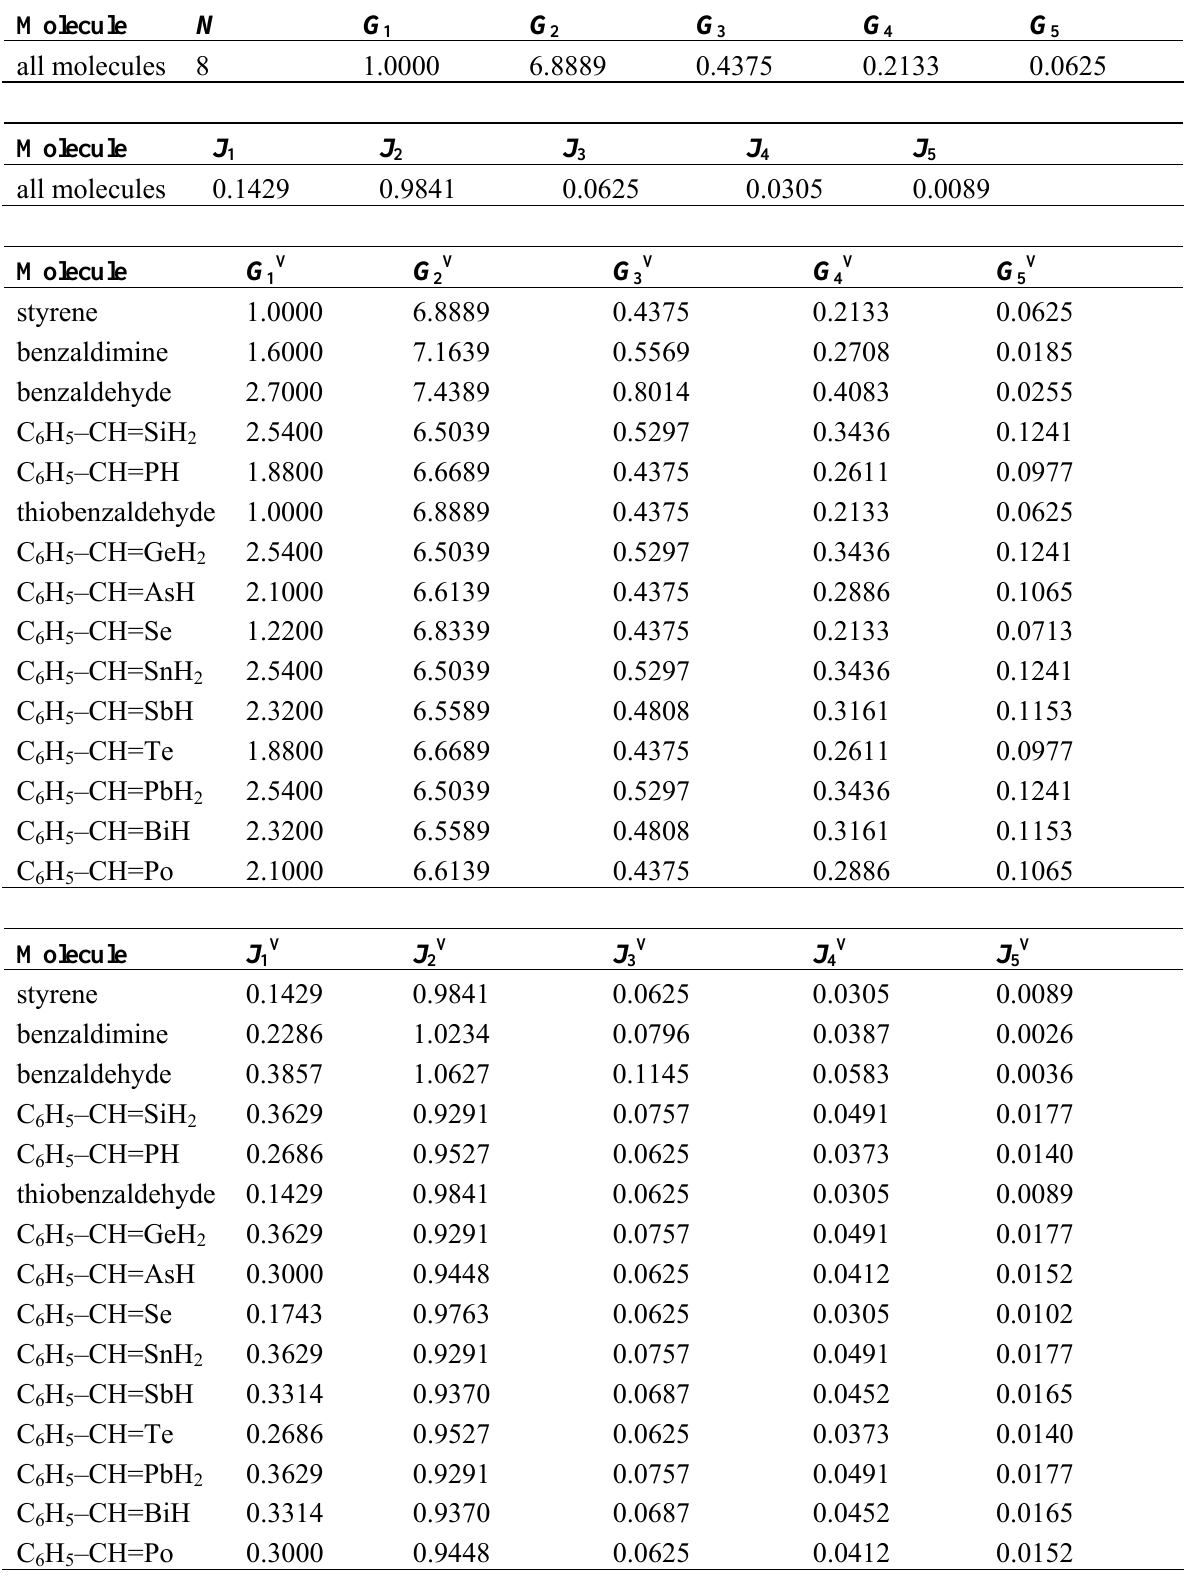
Table 3. Charge indices up to the fifth order for the valence-isoelectronic series of